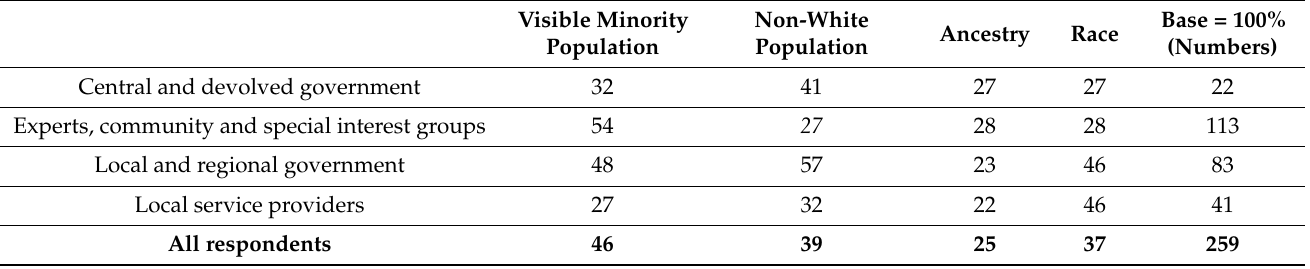
Table 1. Requirements of information for concepts related to ethnicity from the 2011 Census: by organisation type, England and Wales. Visible Minority Non-White Population Population